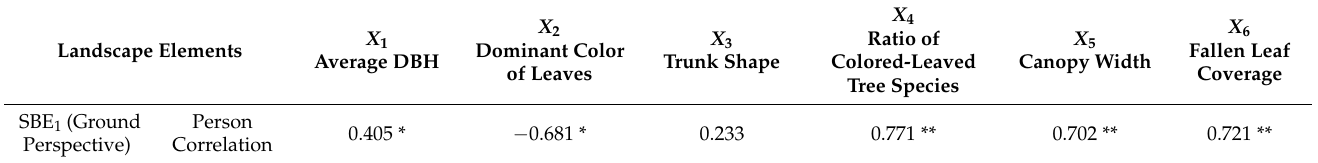
Table 5. Pearson correlation between landscape elements and SBE from the ground perspective.